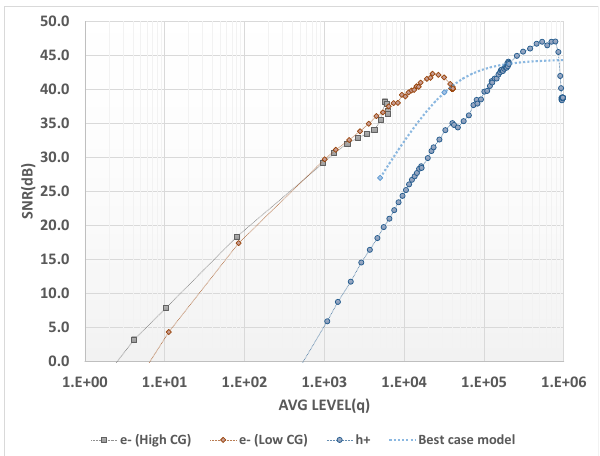
Figure 6. SNR versus charge.